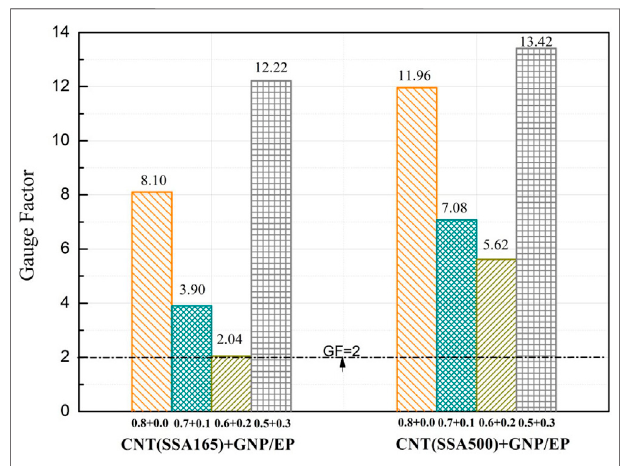
FIGURE9| Theself-sensinggaugefactorofcompositesunder5000 µ ε